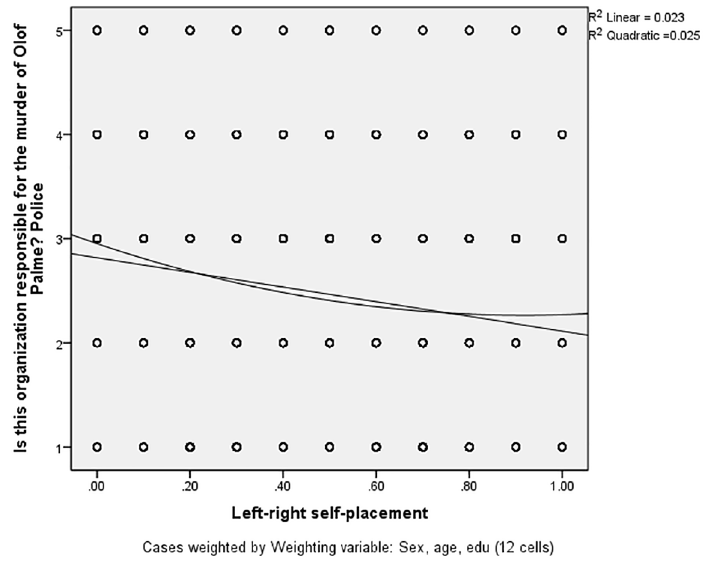
Figure 8. Linear and quadratic relationship between political ideology and belief that the police was responsible for the murder of Olof Palme.